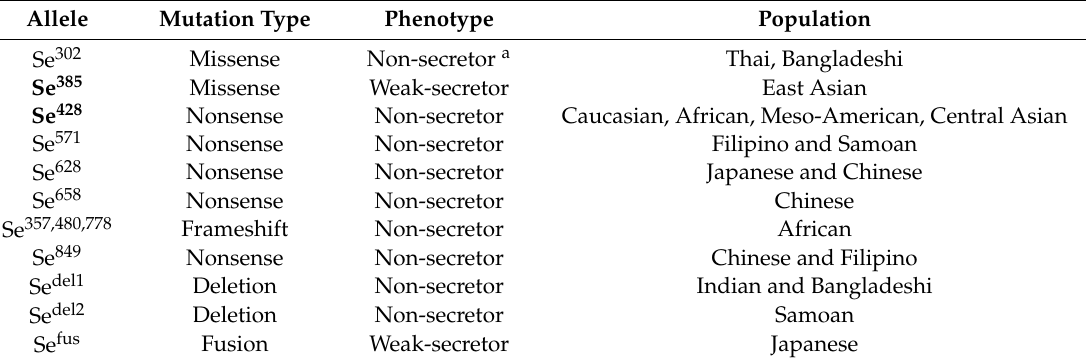
Table 1. FUT2 polymorphisms with known effect on secretor status in different populations. Adapted from [31]. The two most common and investigated in genetic susceptibility studies are highlighted in